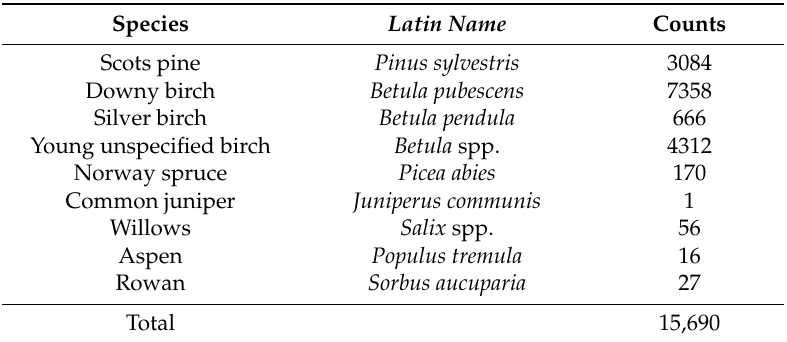
Table 2. Overview of counts per species presented with English and Latin names. The counts represent the sample size for each tree